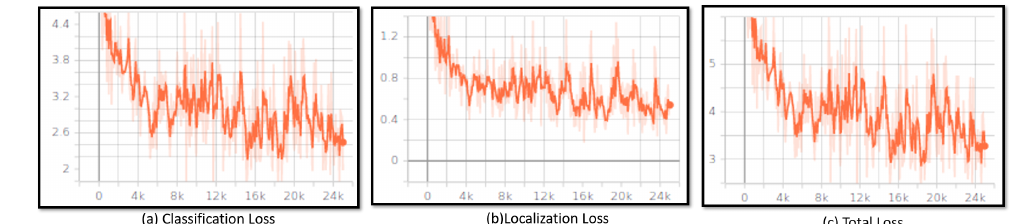
Figure 13. Training